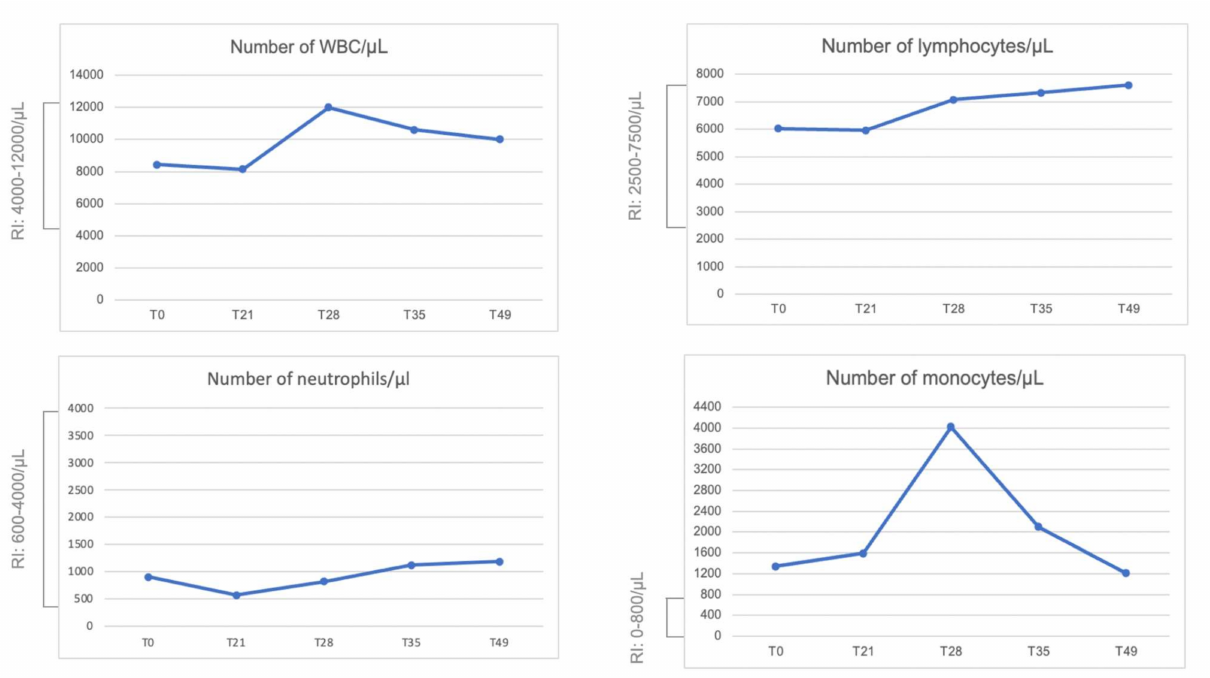
Figure 4. Blood count. Total white blood cells (WBCs), absolute differential number of lymphocytes, neutrophils and monocytes per microliter ( µ L) observed during the monitoring. RI: Reference